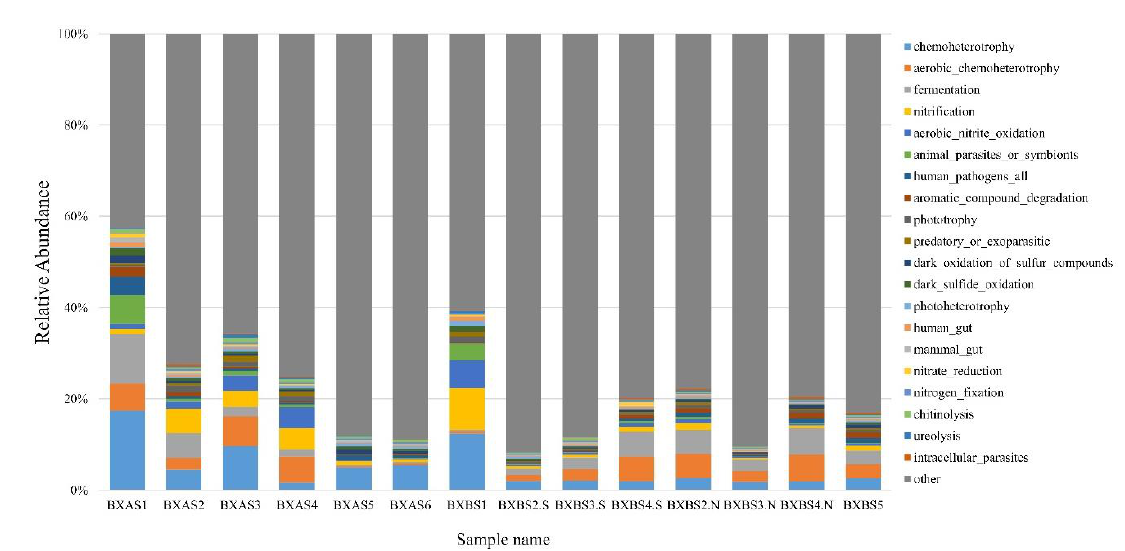
Figure 5. Bar chart of relative abundance of top 20 functions of the sample.